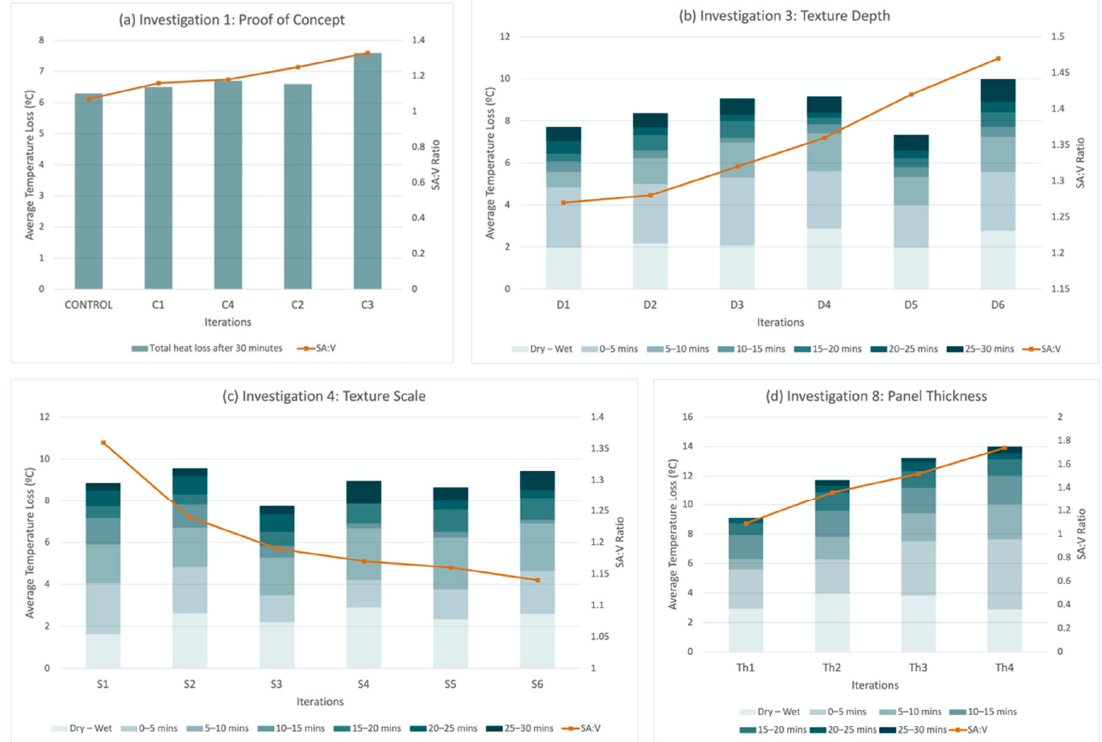
Figure 14. Graphical analysis illustrating the correlation between the SA:V ratio and heat dissipation for different investigations at 5 min intervals: ( a ) Investigation 1—Proof of Concept; ( b ) Investigation 3—Texture Depth; ( c ) Investigation 4—Texture Scale; ( d ) Investigation 8—Panel Thickness.